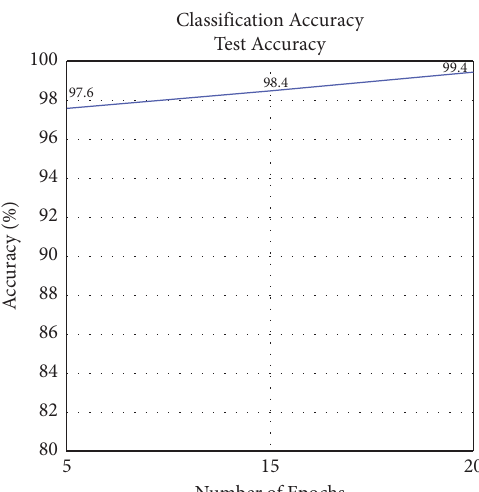
Figure 13: Classifcation accuracy of ResNet using RmsProp optimizer.